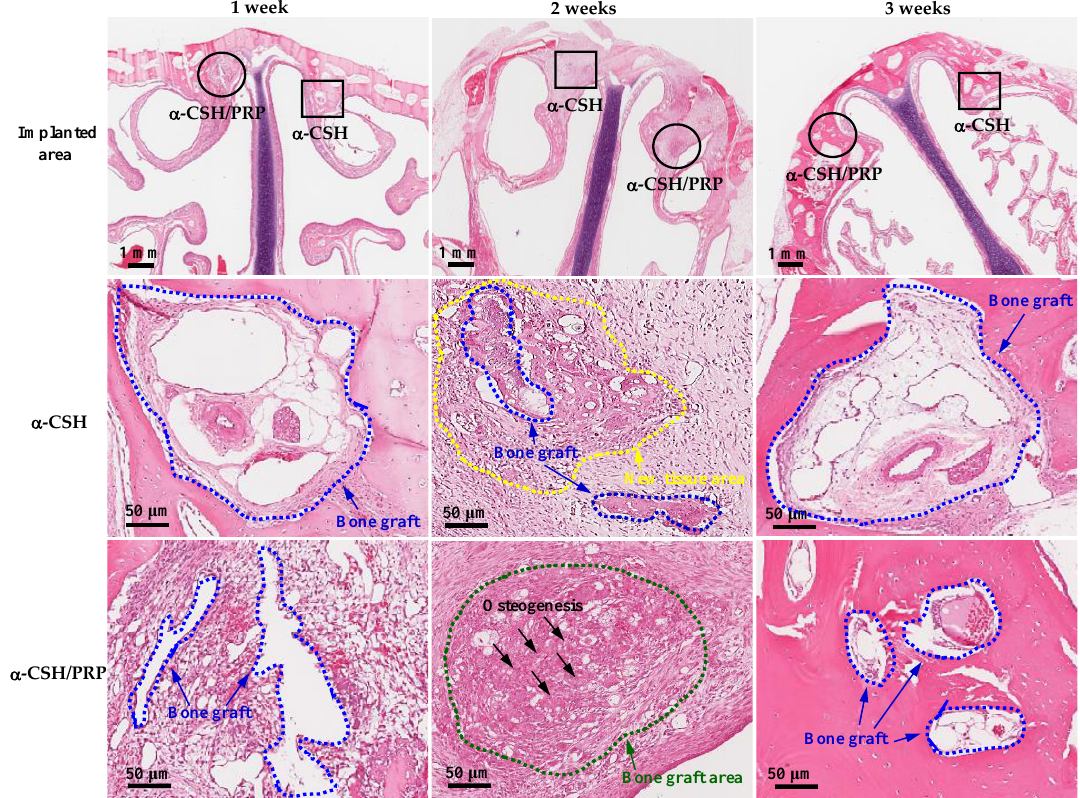
Figure 4. H&E staining results of the α-CSH and α-CSH/PRP at 1, 2, and 3 weeks after implantation. (The higher magnification images were taken from the investigated samples in each time point marked as black circular and rectangular areas, respectively)